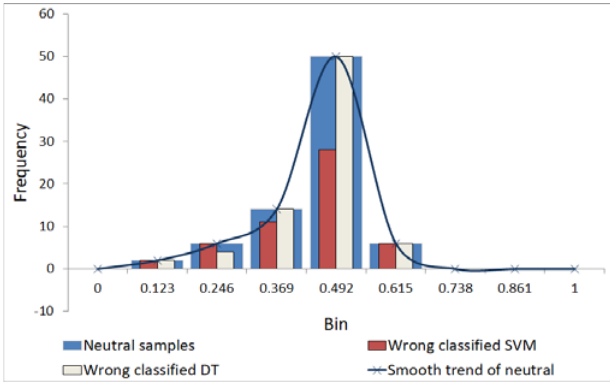
Figure 11. Histogram of Neutral samples.